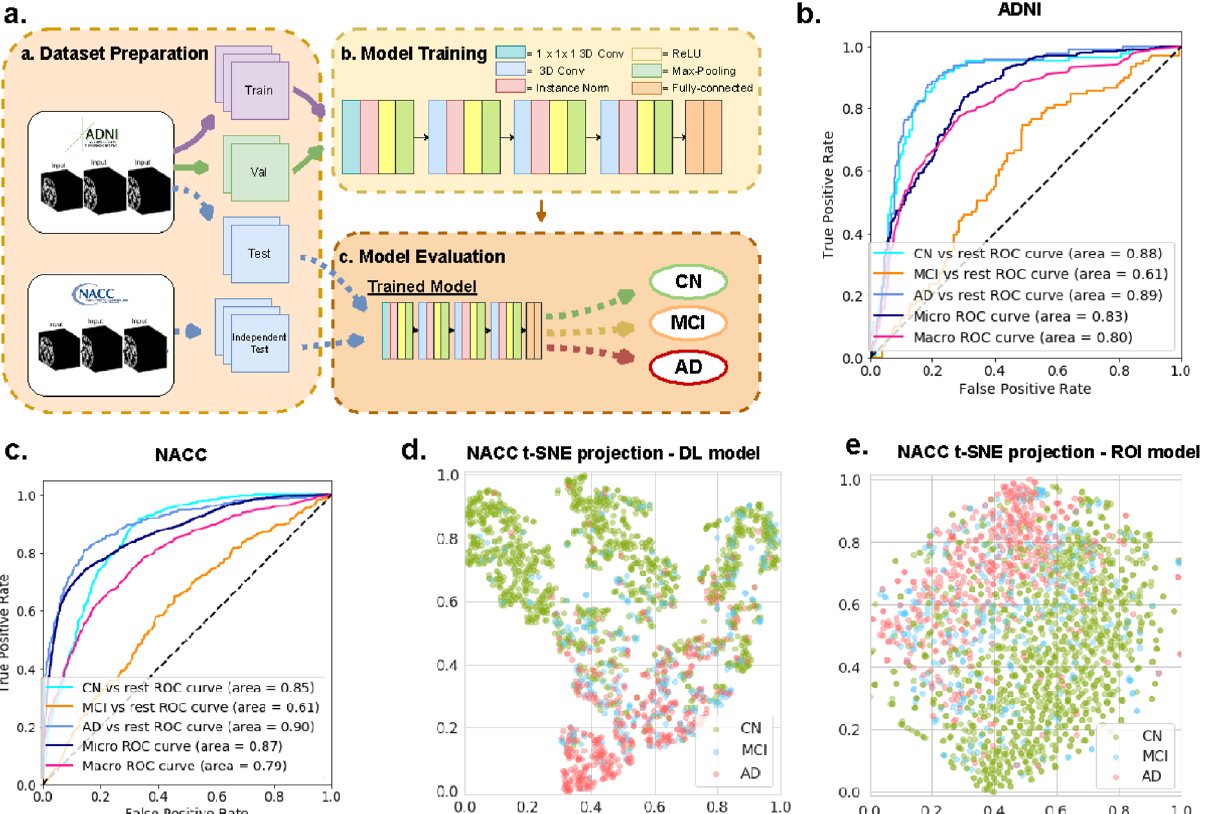
Figure 1. Overview of the deep learning framework and performance for Alzheimer’s automatic diagnosis. ( a ) Deep learning framework used for automatic diagnosis. ( b ) Receiver operating characteristic (ROC) curves for classification of cognitively normal (CN), mild cognitive impairment (MCI) and Alzheimer’s disease (AD), computed on the ADNI held-out test set. ( c ) ROC curves for classification of cognitively normal (CN), mild cognitive impairment (MCI) and Alzheimer’s disease (AD) on the NACC test set. ( d ) Visualization using t-SNE projections of the features computed by the proposed deep-learning model. Each point represents a scan. Green, blue, red colors indicate predicted cognitive groups. CN and AD scans are clearly clustered. ( e ) Visualization using t-SNE projections of the 138 volumes and thickness in the ROI-volume/thickness model. Compared to ( d ) the separation between CN and AD scans is less marked. The t-SNE approach is described in details in the methods section.